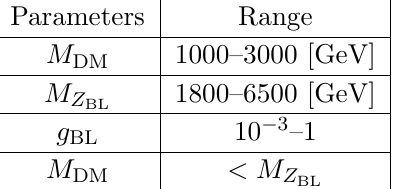
M Z ( M DM (cid:27) SI ) plane after satisfying BL (cid:0) (cid:0) = M N 0 = 361 : 4 GeV, M N = M N 0 = 296 : 2 1 2 1 2